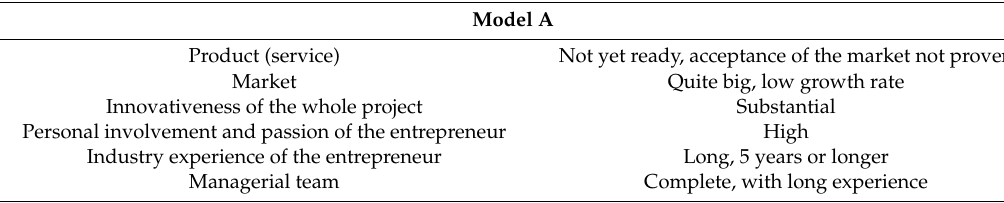
Table 3. One of eight cards used for the conjoint experiment in the study.